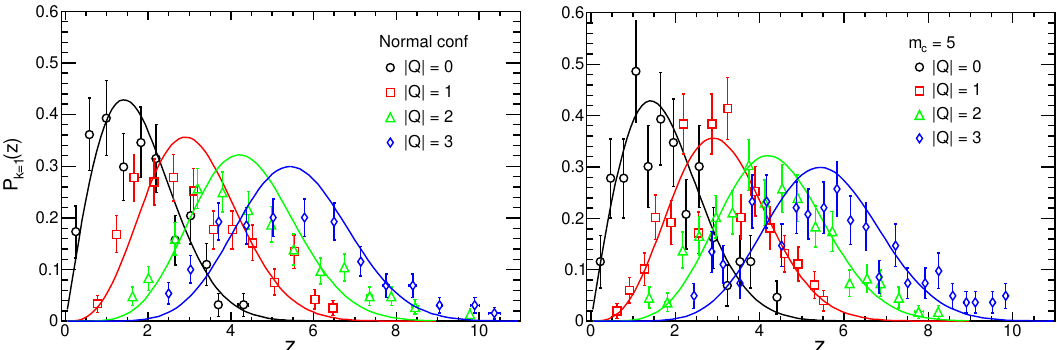
Figure 8 . The distributions of the (cid:12)rst eigenvalues of each topological charge sector j Q j = 0 ; 1 ; 2 ; 3. The normal con(cid:12)gurations (left) and the con(cid:12)gurations of the magnetic charge m c = 5 (right) are used. The colored symbols demonstrate the distributions that are re-scaled with the scale parameter (cid:6) b . The colored lines indicate the distributions of the chRMT.